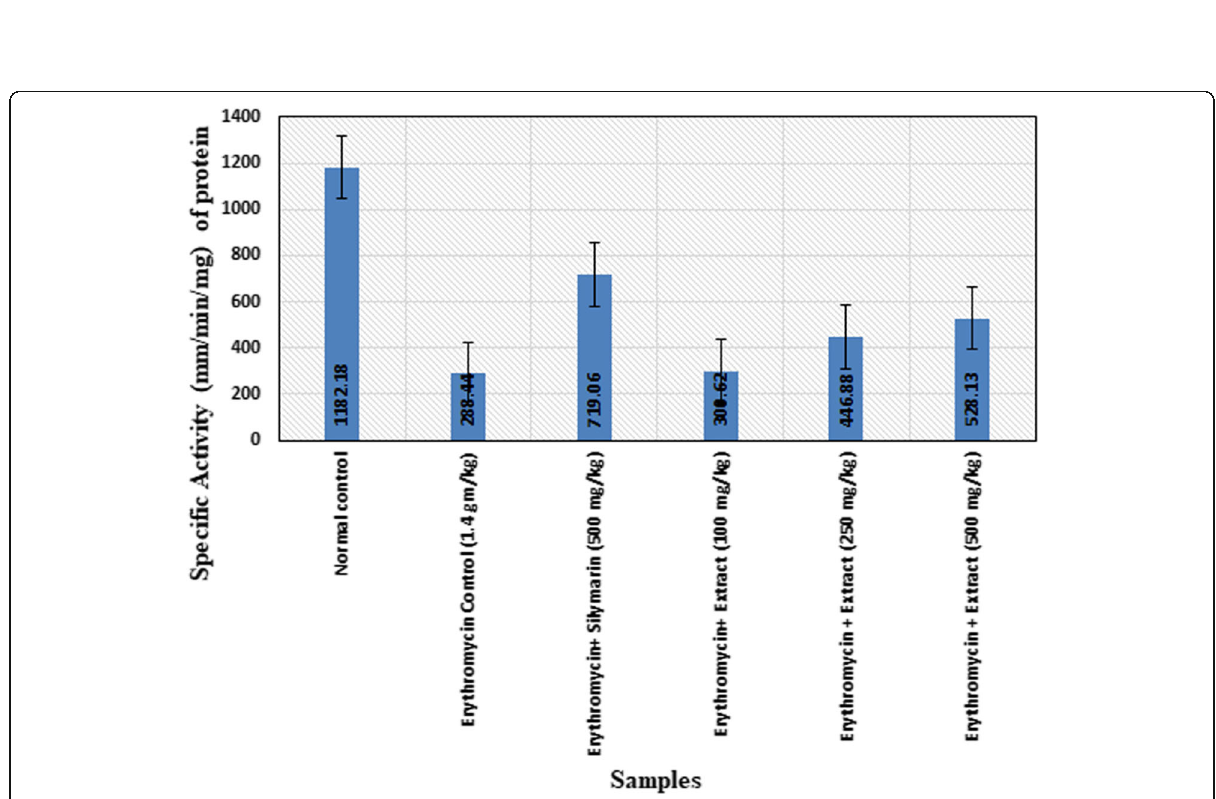
Fig. 3 The antioxidant enzyme (catalase) level in Erythromycin-induced liver